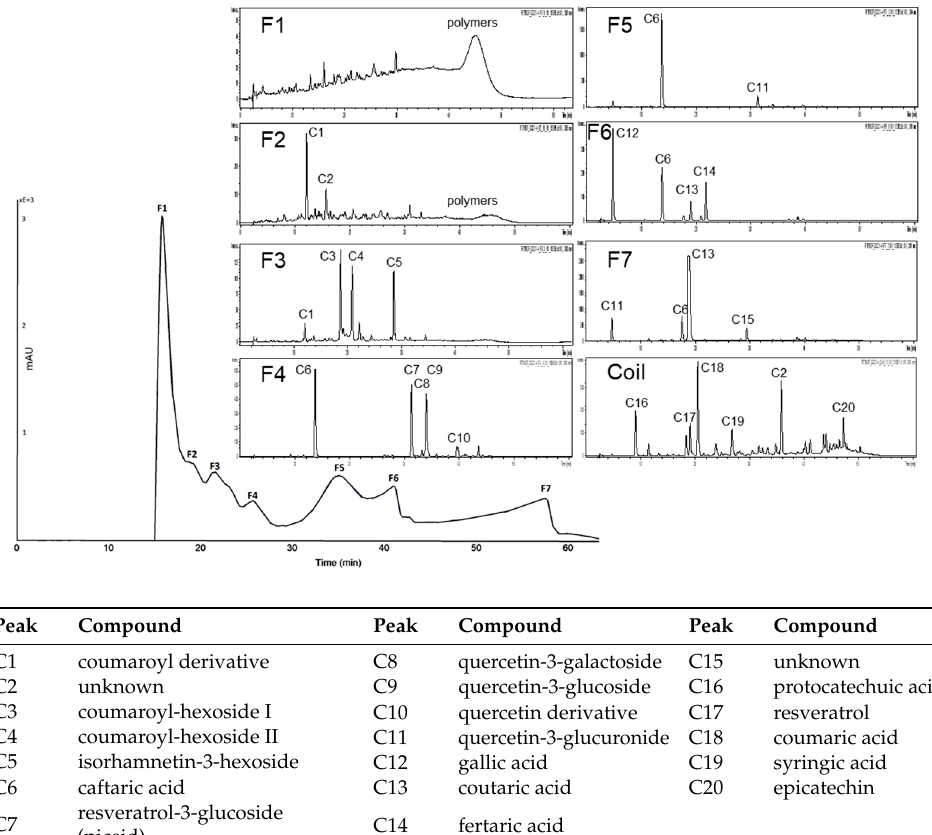
Figure 5. HPCCC chromatogram at a wavelength of λ 320 nm of the copigment fraction of the red grape JC sample and HPLC-ESI-MS/MS chromatograms indicating the composition of each fraction.